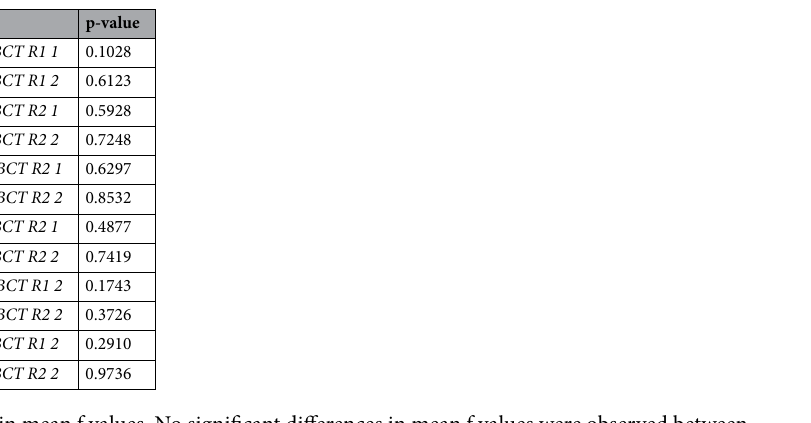
(Table 2). Comparison of furcation volume.